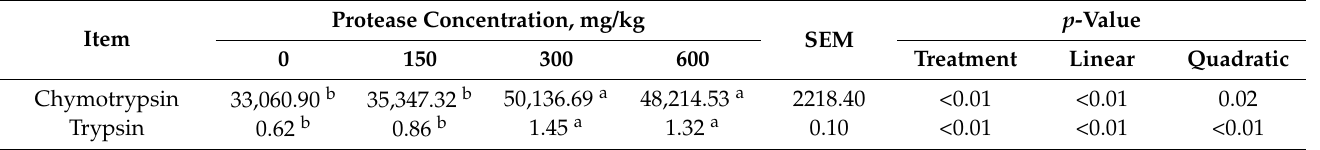
Table 10. Effects of protease supplementation on jejunum digestive enzyme activities in weaned piglets (U/mg prot).